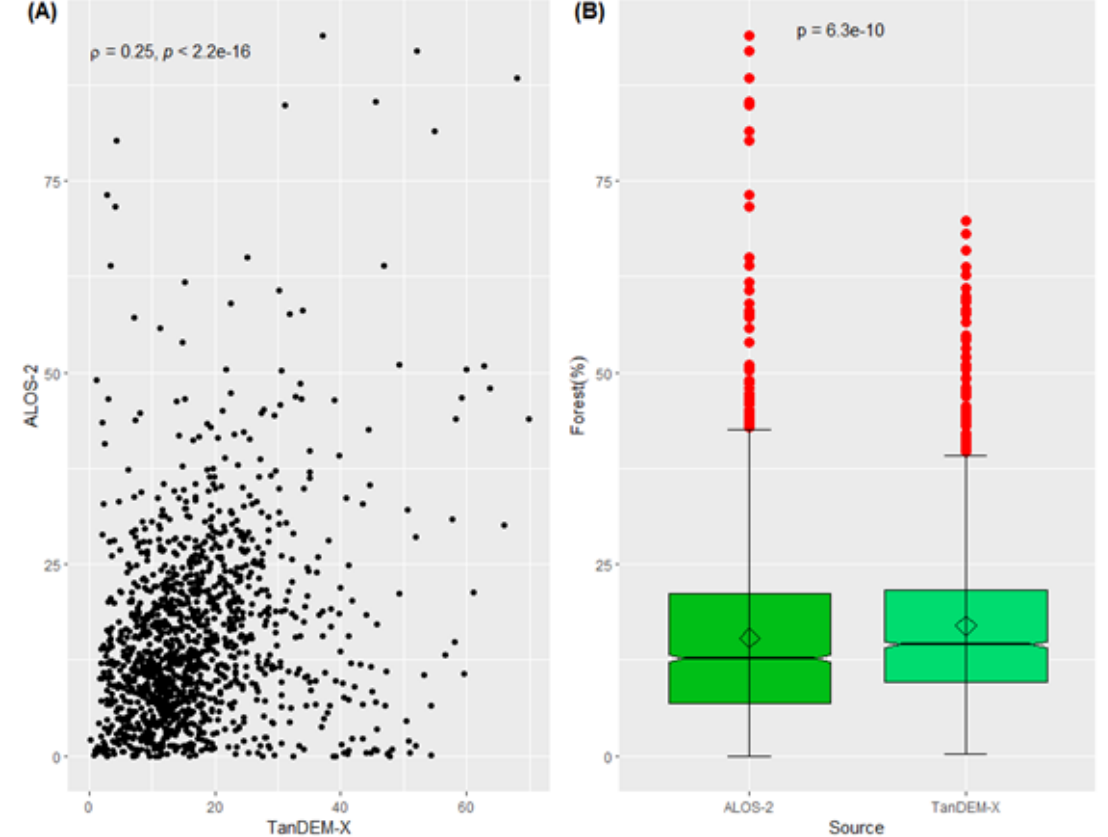
Figure 11. Relationship between the percentage of forest estimations obtained by the TanDEM-X and ALOS-2 data sets ( A ) and the results of the Wilcoxon test ( B ) over the Cerrado biome at the municipality level.